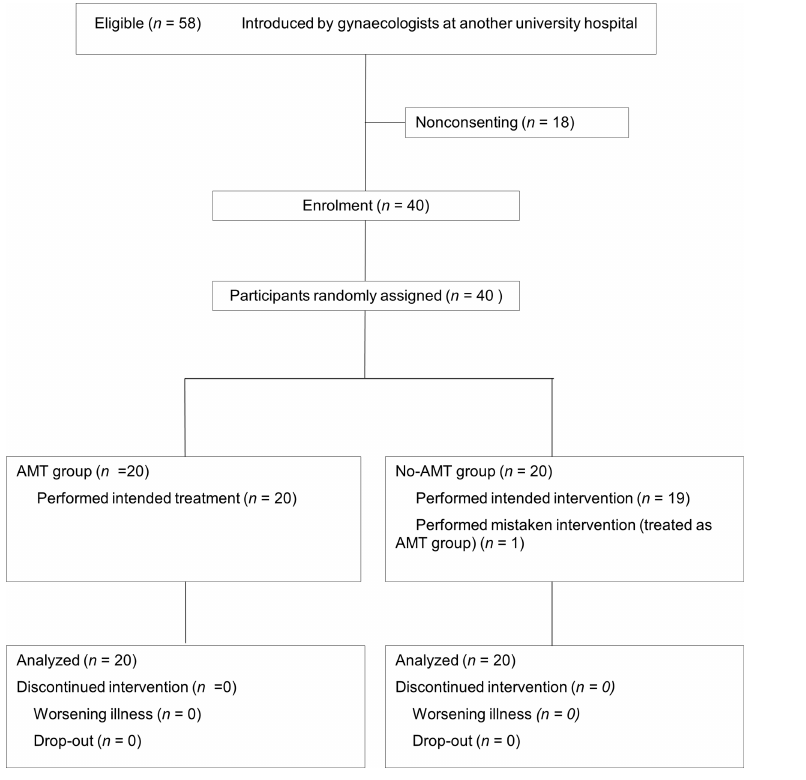
Fig 1. CONSORT flowchart of participant recruitment [11]. AMT: Anma massage therapy.